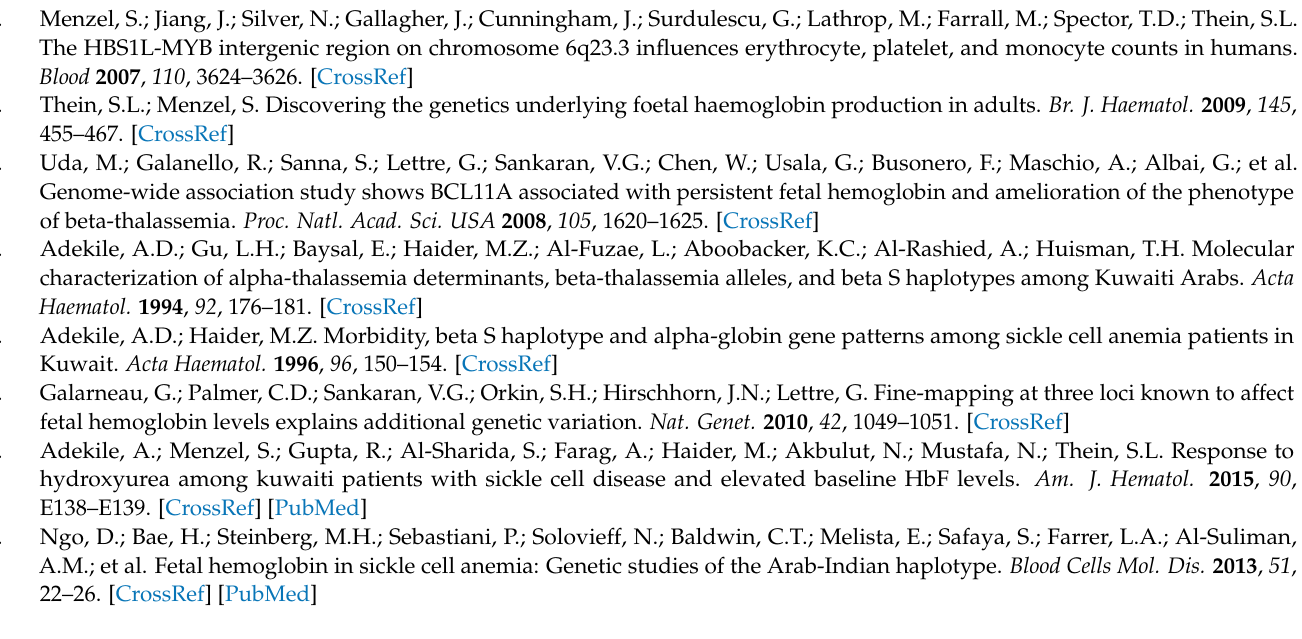
Supplementary Materials: The following are available online at https://www.mdpi.com/article/ 10.3390/jpm11060567/s1, Figure S1: Distribution of HbF levels among patients, Table S1: Fetal hemoglobin association results for 24 SNPs at the BCL11A locus in Kuwaiti patients with SCD, Table S2: Fetal hemoglobin association results for 36 SNPs at the HBS1L-MYB locus in Kuwaiti patients with SCD, Table S3: Fetal hemoglobin association results for 52 SNPs at the HBB locus in Kuwaiti patients with SCD, Table S4: Fetal hemoglobin association results for 4 SNPs at the ChrX in Kuwaiti patients with